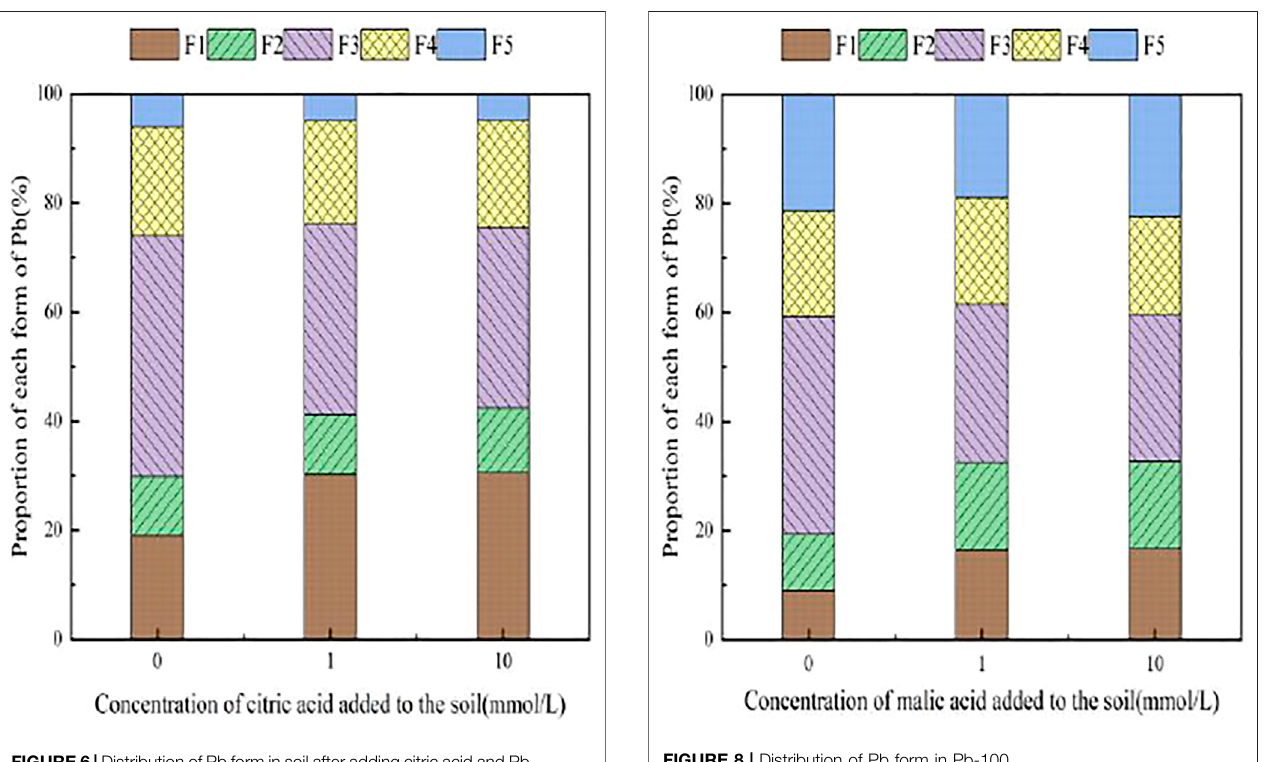
FIGURE 6| Distribution of Pb form in soil after adding citric acid and Pb- 800 soil after adding citric acid.